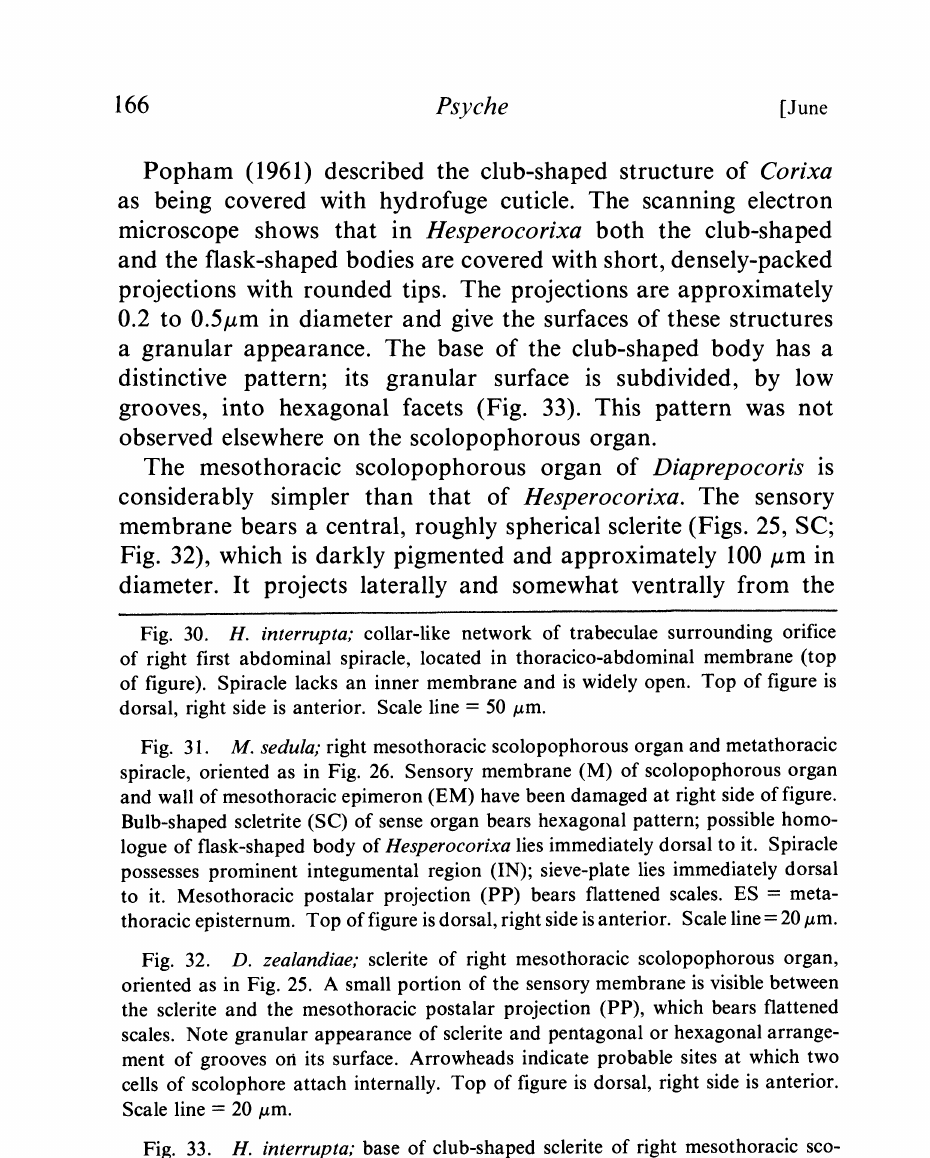
Fig. 30. H. interrupta; collar-like network of trabeculae surrounding orifice of right first abdominal spiracle, located in thoracico-abdominal membrane (top of figure). Spiracle lacks an inner membrane and is widely open. Top of figure is dorsal, right side is anterior. Scale line 50 #m. Fig. 31. M. sedula; right mesothoracic scolopophorous organ and metathoracic spiracle, oriented as in Fig. 26. Sensory membrane (M) of scolopophorous organ and wall of mesothoracic epimeron (EM) have been damaged at right side of figure. Bulb-shaped scletrite (SC) of sense organ bears hexagonal pattern; possible homo- logue of flask-shaped body of Hesperocorixa lies immediately dorsal to it. Spiracle possesses prominent integumental region (IN); sieve-plate lies immediately dorsal to it. Mesothoracic postalar projection (PP) bears flattened scales. ES meta- thoracic episternum. Top of figure is dorsal, right side is anterior. Scale line 20 #m. Fig. 32. D. zealandiae; sclerite of right mesothoracic scolopophorous organ, oriented as in Fig. 25. A small portion of the sensory membrane is visible between the sclerite and the mesothoracic postalar projection (PP), which bears flattened scales. Note granular appearance of sclerite and pentagonal or hexagonal arrange- ment of grooves ori its surface. Arrowheads indicate probable sites at which two cells of scolophore attach internally. Top of figure is dorsal, right side is anterior. Scale line 20 #m. Fig. 33. H. interrupta; base of club-shaped sclerite of right mesothoracic sco- lopophorous organ, showing granular appearance and hexagonal pattern of grooves. Scolophore attaches on internal surface of knob (SA) on base; shaft of club-shaped sclerite extends posteriorly (left side of figure) from site of scolophore attachment. Specimen has been tilted ventromedially, concealing sensory membrane. FL part of flask-shaped body. EM mesothoracic epimeron. Sieve-plate of metathoracie spiracle appears at lower left. Top of figure is dorsal, right side is anterior. Scale line 20